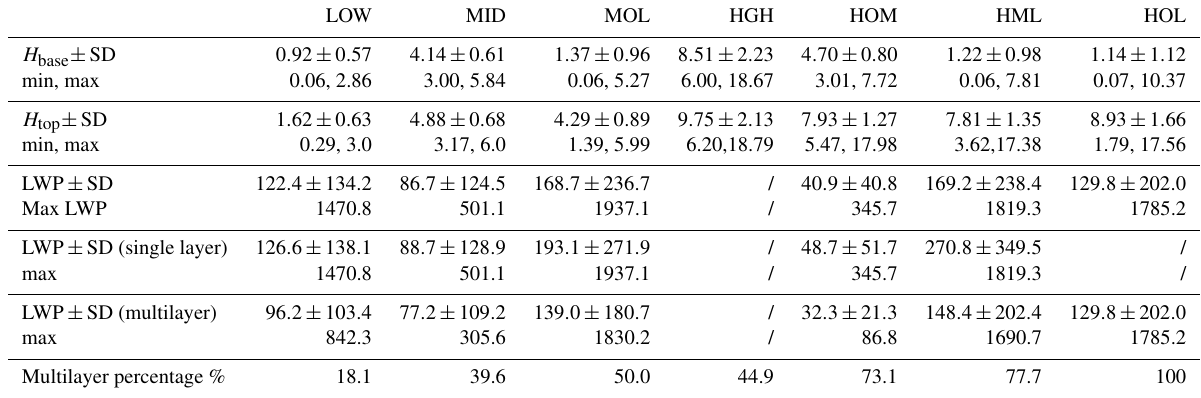
Table 2. Mean, standard deviation, minimum and maximum cloud base heights ( H base ), cloud-top heights ( H top ), and LWPs (all samples, single layered, and multilayered) of all seven types of clouds over the SO. All cloud heights have units in kilometers, and LWP has a unit of grams per square meter (gm − 2